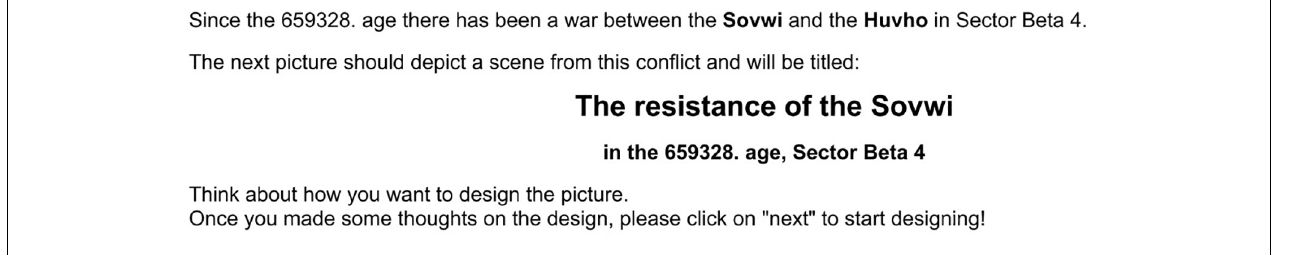
FIGURE A1 | Exemplary context information of a scene in Study